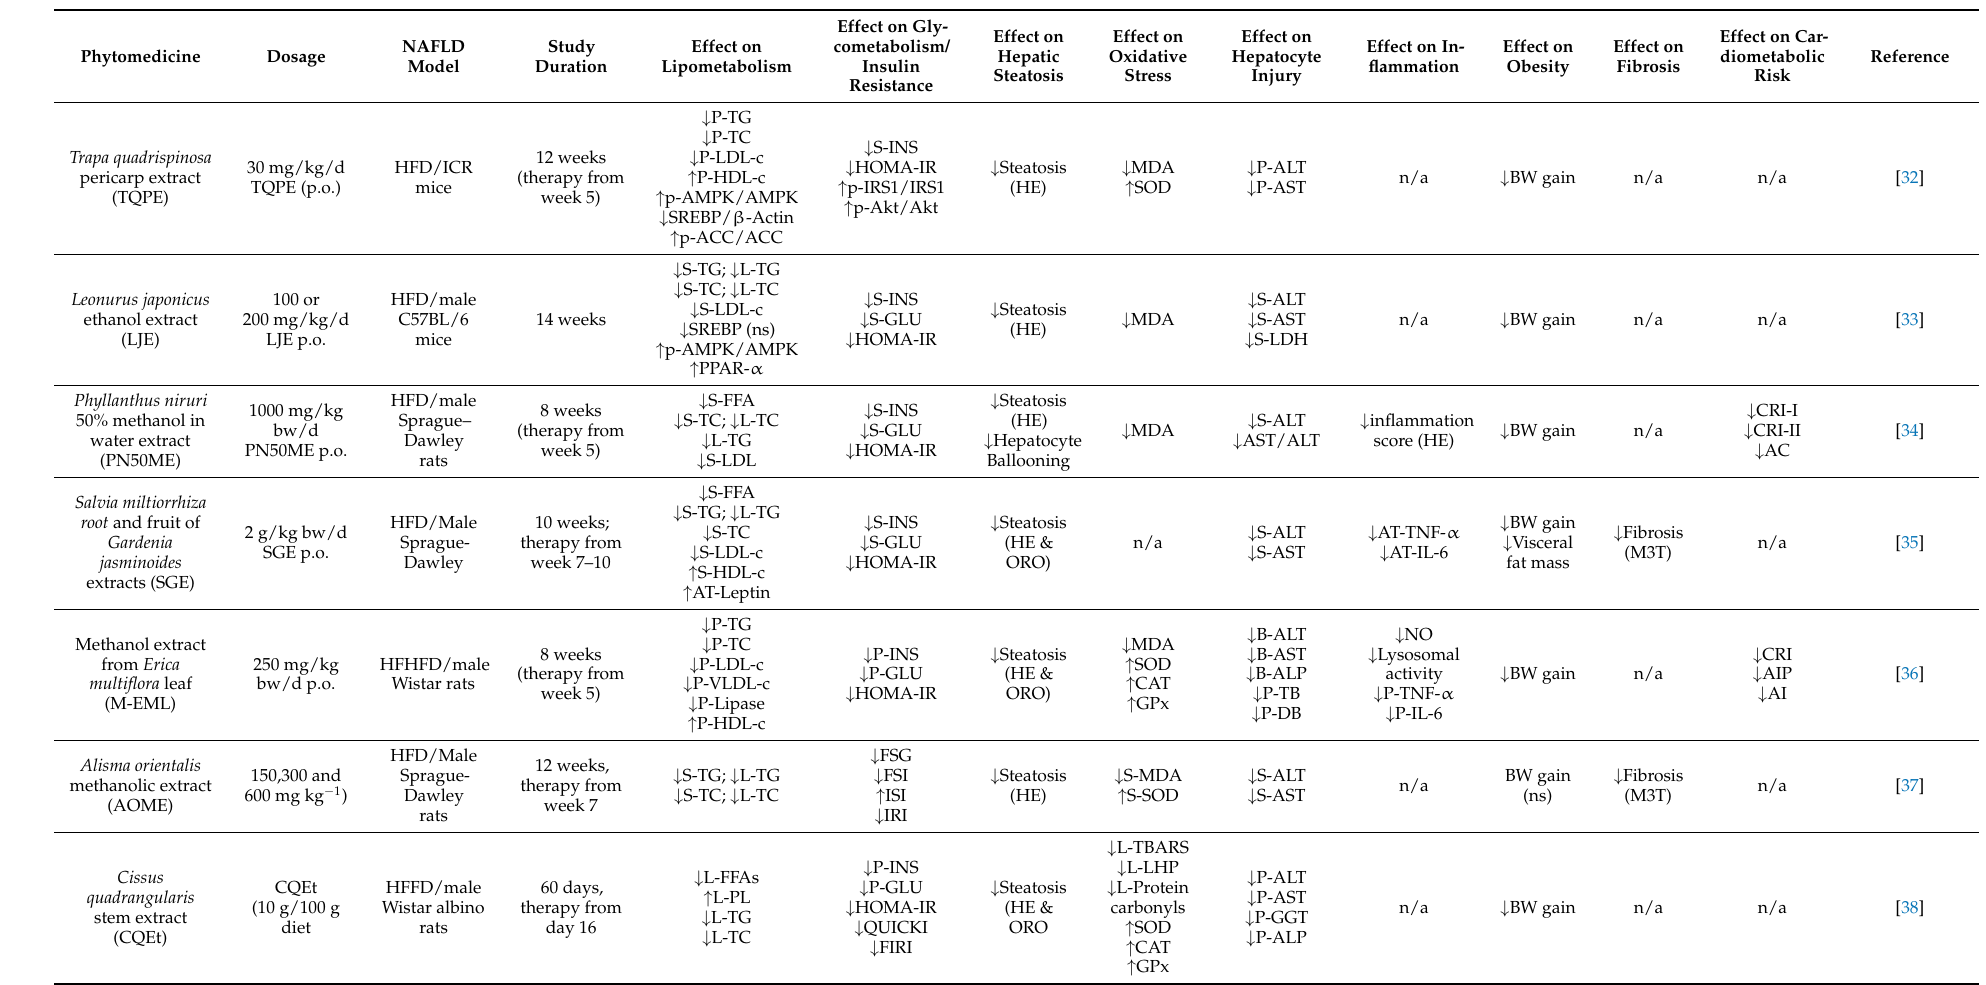
Table 2. Characteristics of the included